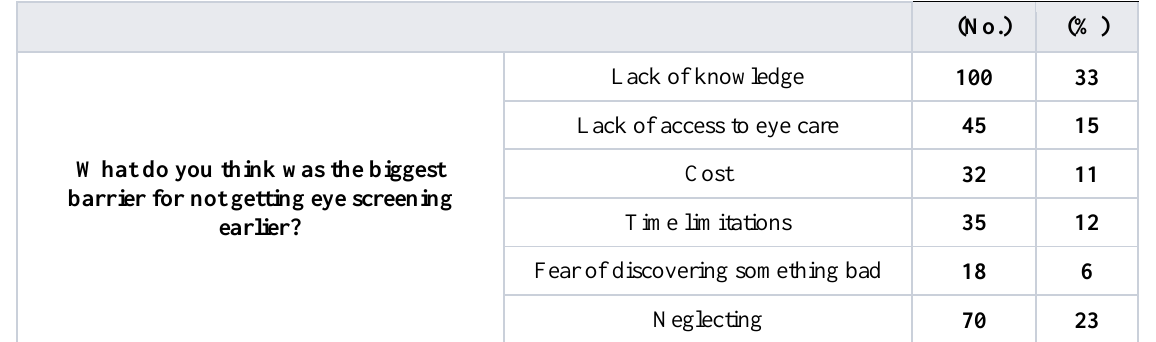
Table (4): The studied sample according to personal barriers to compliance with regular follow up